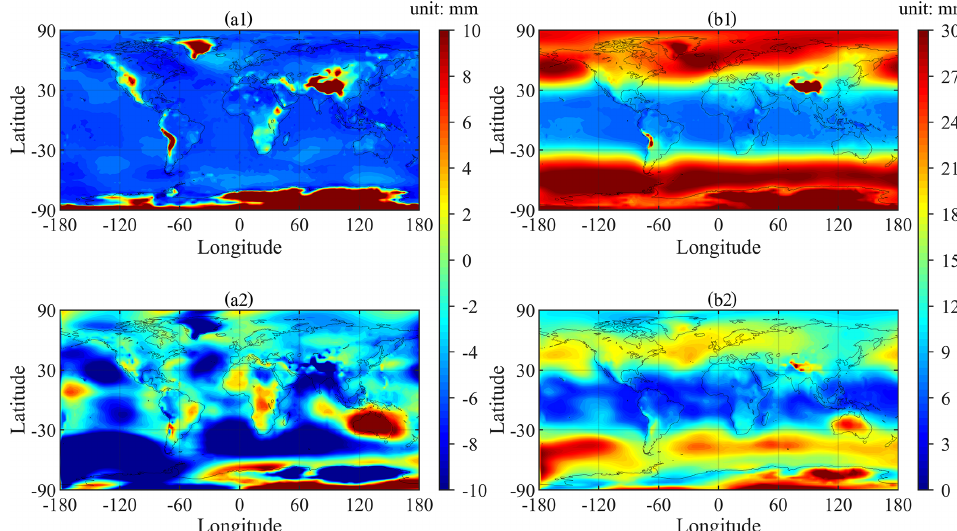
Figure 8. Bias (a1) and RMSE (b1) of ZHD-GPT3 and bias (a2) and RMSE (b2) of ZHD-GZHD over each global grid point (the horizontal resolution: 2 . 5 ◦ × 2 . 5 ◦ ) during the 19-year period of 2000–2019 (reference: